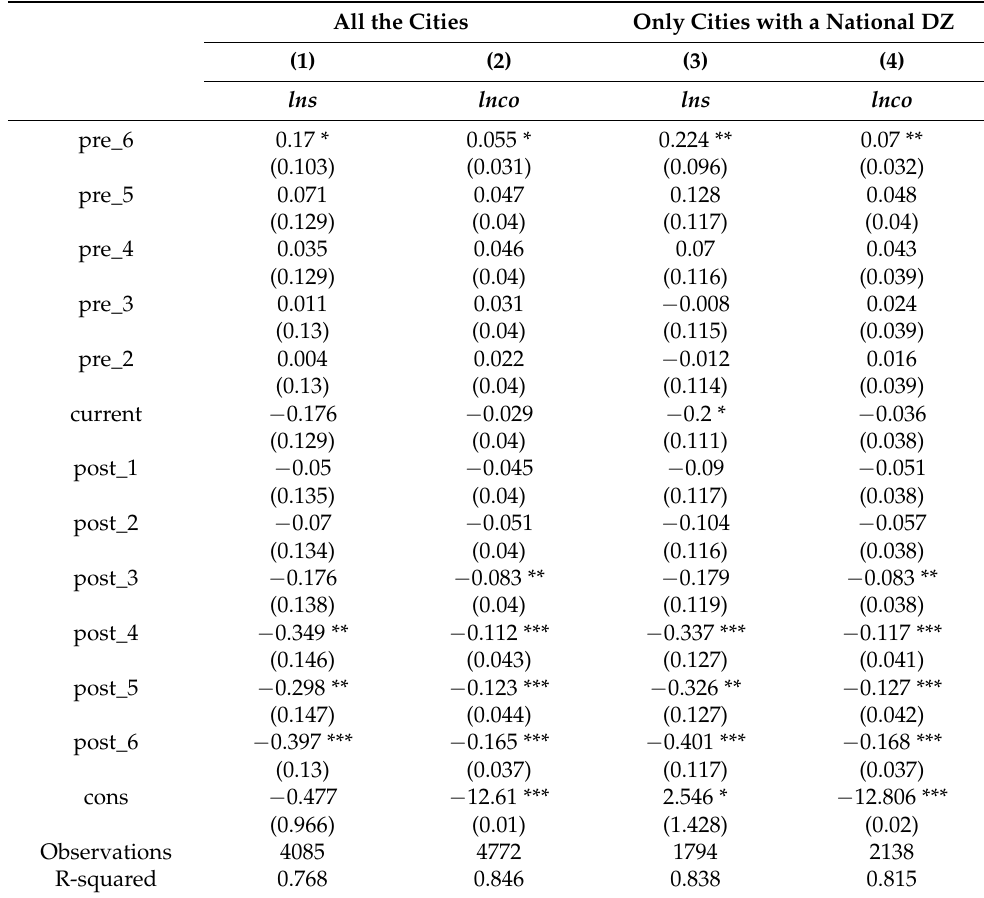
Table 10. Parallel Trend Tests and Dynamic